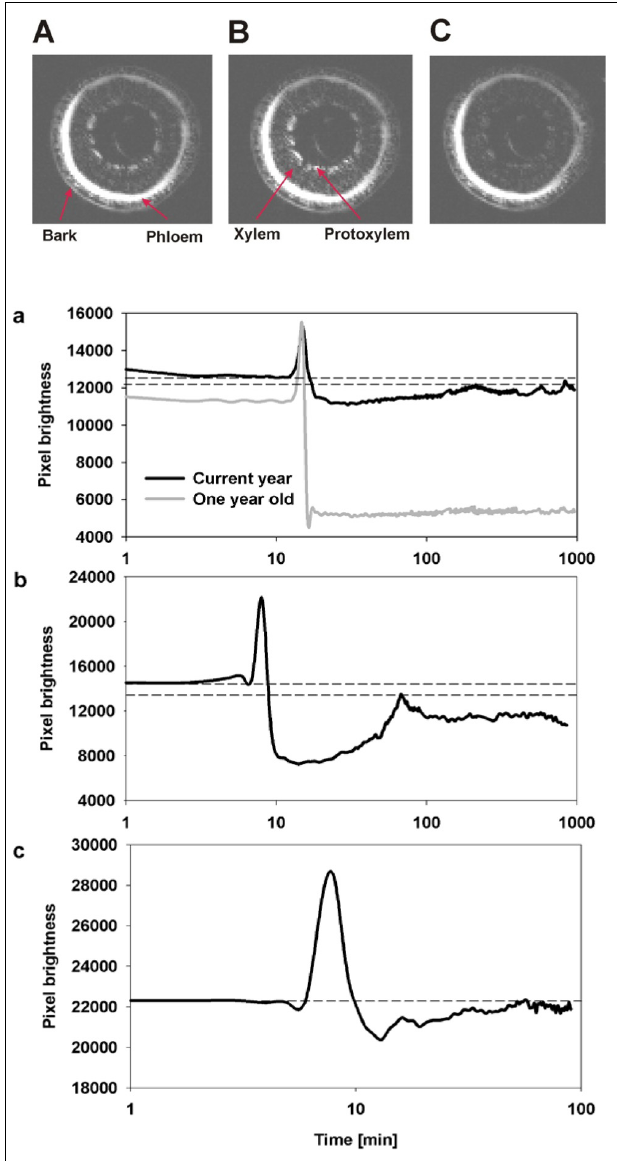
FIGURE 2 | Representative MRI images of three consecutive observations of the state of water status of xylem from current-year extension growth (A) before air injection, (B) during air injection, and (C) 10 min after air injection are shown. The images (A,C) reflect the changes in pixel brightness after the successful induction of embolism from air injection.The temporal increase of brightness observed in image (B) compared to (A,C) reflects the movement of water during the injection of air into the stem.The three figures below (a–c) are an analysis of changes in the average pixel brightness measured on the xylem conducting area from three experimental plants. Panel (a) displays analysis of two xylem growth rings simultaneously, and shows a lack of refilling in the 1-year-old ring as seen by the drop in average brightness to a new lower constant level while refilling was observed in the current-year growth ring as shown by the initial decrease in pixel brightness followed by a period of brightness increase. Panels (b,c) are measurements on current extension growth only and both show refilling following air injectionasthe initial decrease in pixel brightness is followed by an increase in pixel brightness. Dashed lines reflect the initial (prior to embolism induction) and the maximum final (recovered) levels of pixel